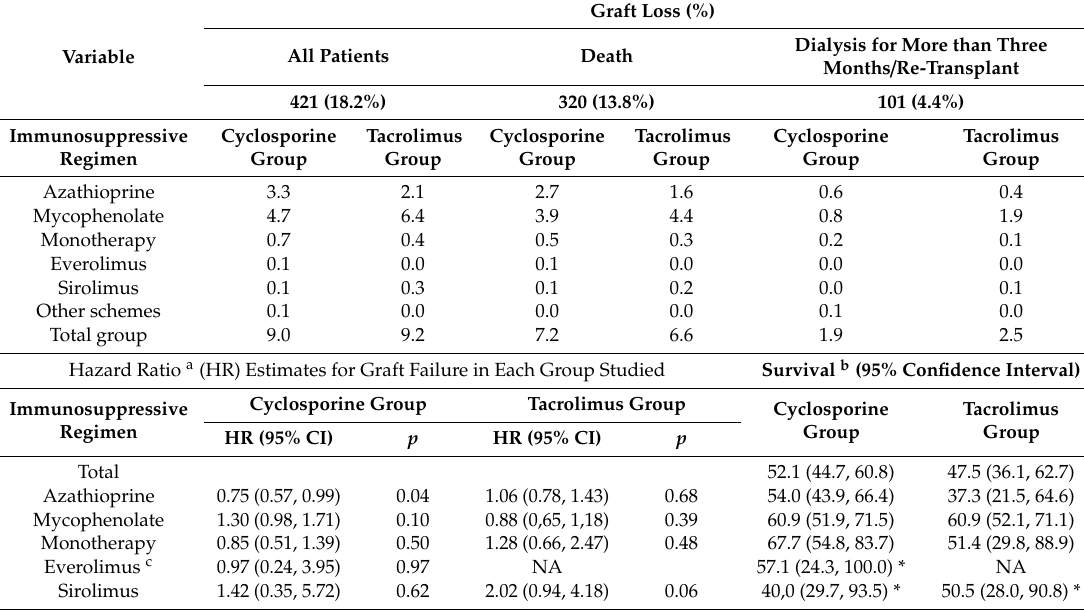
Table 2. Outcome measures of e ff ectiveness of the study patients in a matched cohort (Brazil, 2000 to 2015; n = 2318).